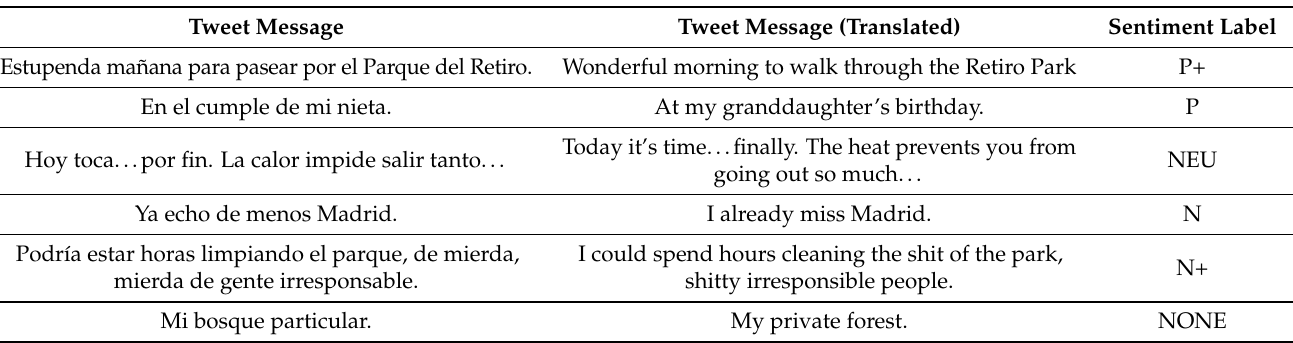
Table 3. Examples of tweets annotated with a sentiment label. Tweet